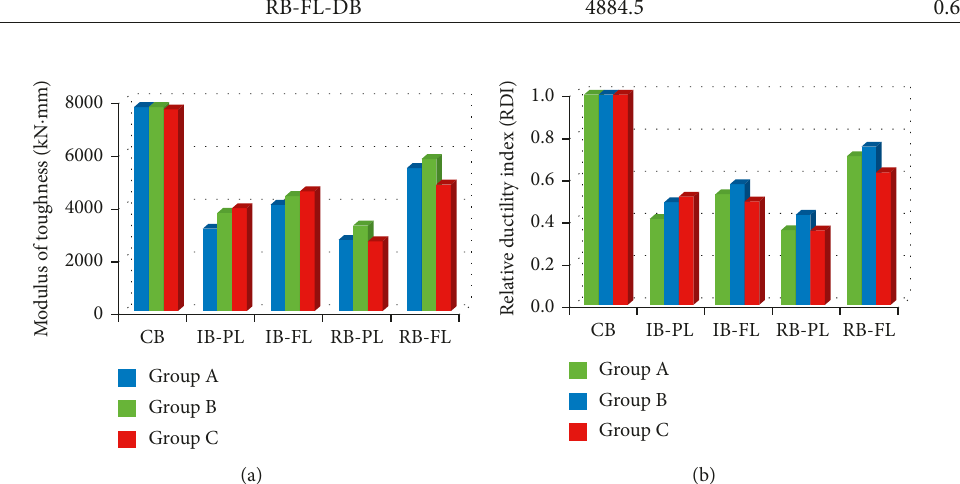
Figure 14: Ductility capacities. (a) Modulus of toughness. (b) Relative ductility